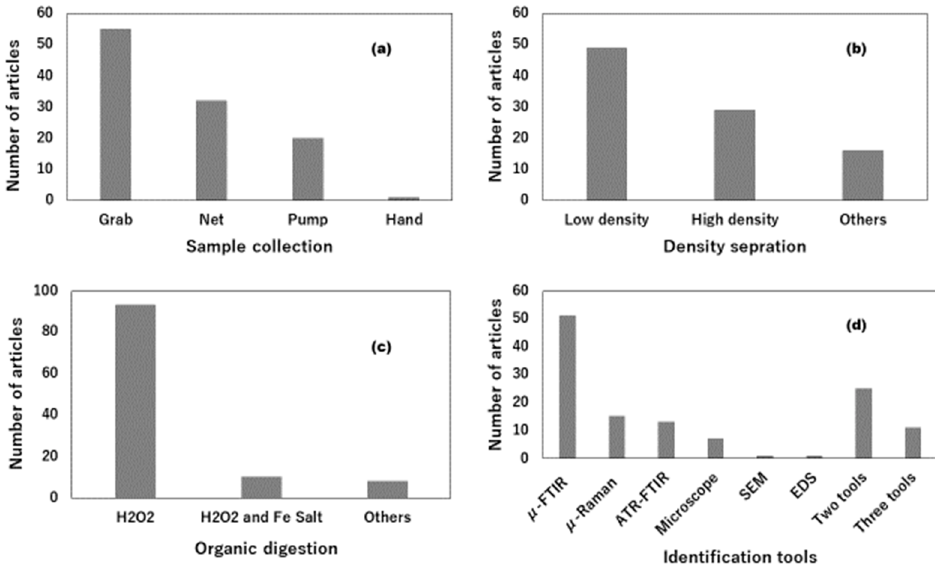
Figure 12. Summary for different steps of methodology ( a ) Sample collection, ( b ) Density separation, ( c ) Digestion of organic matter, and ( d ) Identification tools used to study MPs in the reviewed research